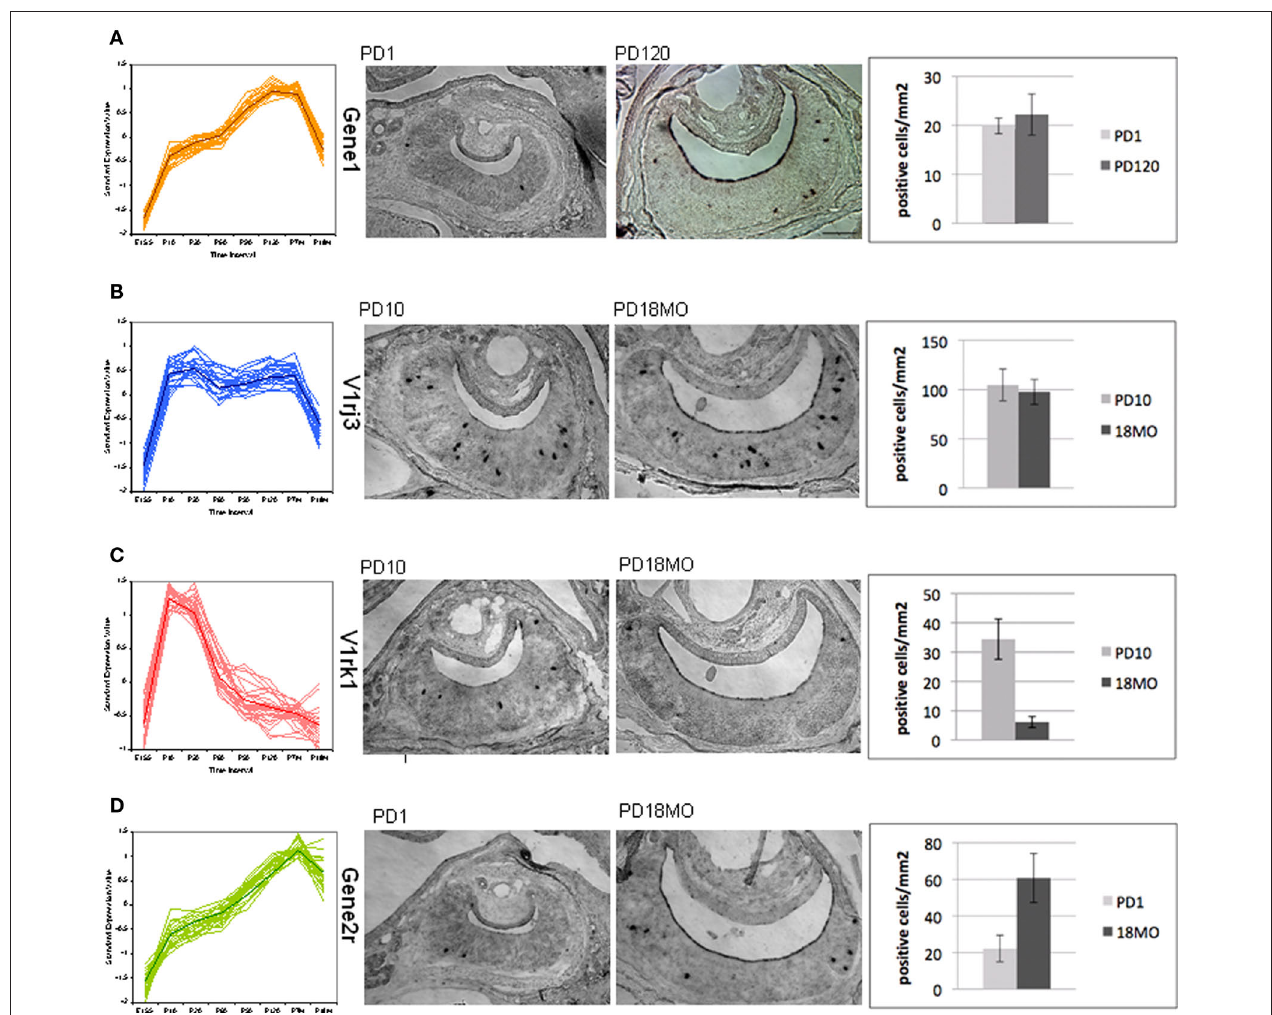
FiGuRe 7 | Temporal expression change of VR genes confirmed by in situ hybridization. One gene was selected from four main patterns shown in Figure 5 for in situ hybridization. The number of VR expressing vomeronasal sensory neurons at different developmental time points was counted with representative slides. In situ hybridization was performed in coronal sections of mouse VNO using digoxigenin-labeled antisense RNA